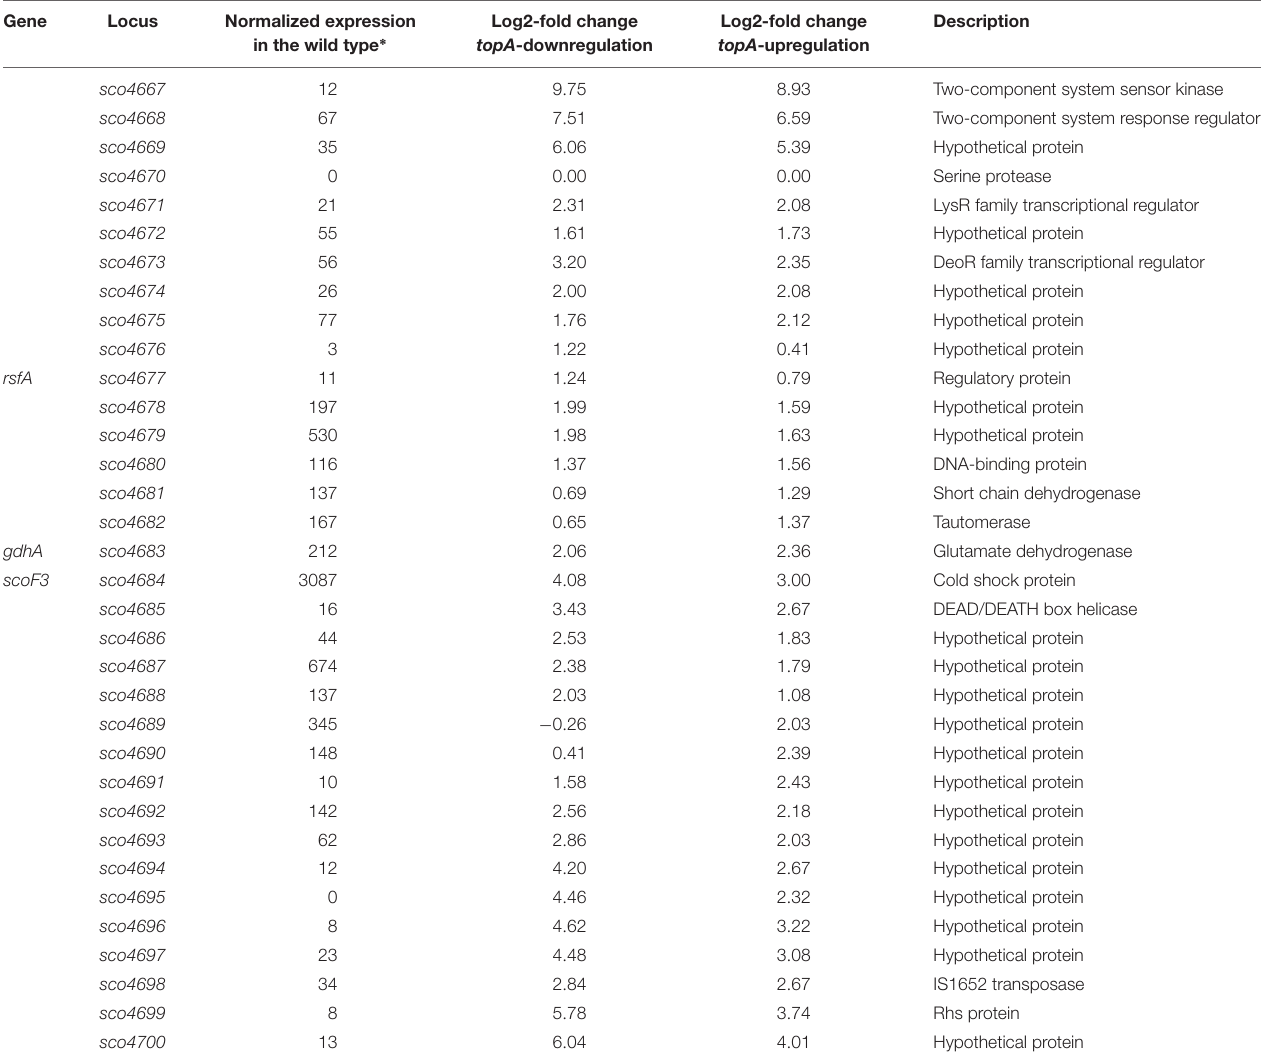
TABLE 3 | Transcription of genes in the SHC region at constitutive topA -down- or upregulation (based on RNA-Seq data). Gene Locus Normalized expression Log2-fold change Log2-fold change in the wild type ∗ topA -downregulation topA